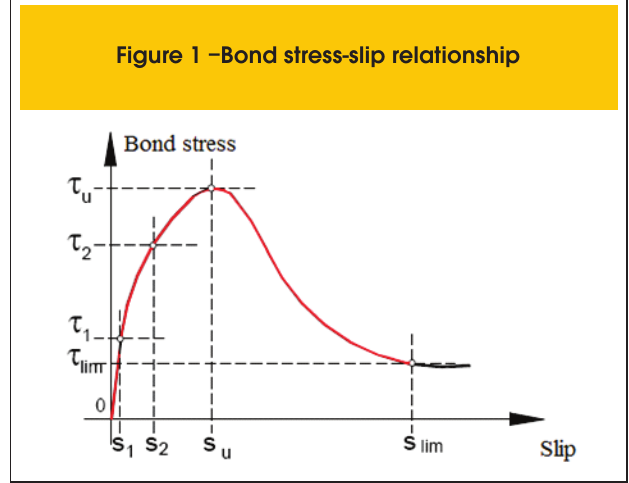
Figure 1 –Bond stress-slip